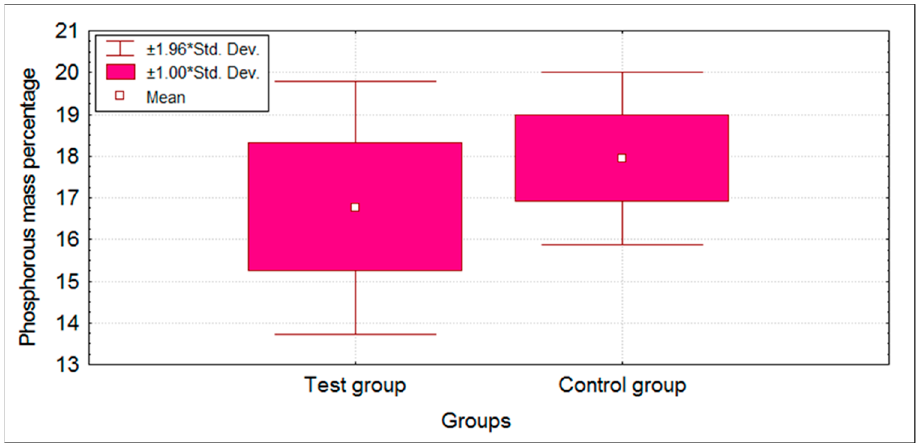
Figure 4. Box plot showing mean Calcium mass percentage scores of test and control groups. * standard deviation.